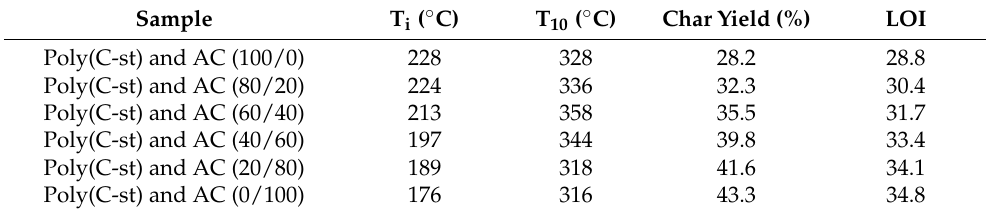
Table 4. Data obtained from TGA